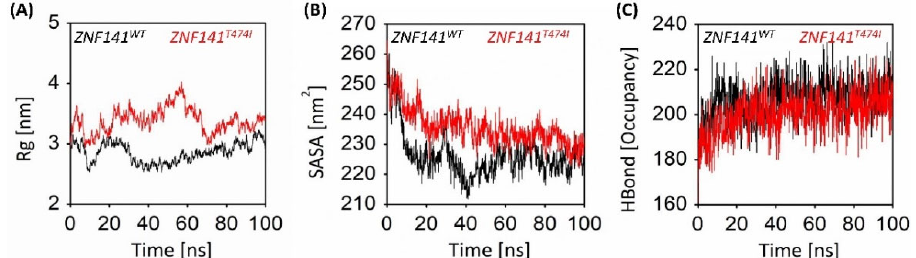
Figure 4. Radius of gyration, Solvent accessible surface area, and Hydrogen bond analysis for ZNF141 protein shows a significant correlation between gyration and solvent accessible area. ( A ) The radius of Gyration analysis for wt-ZNF41 and mutant T474I through the course of 100 ns molecular dynamics simulation. ( B ) The solvent-accessible surface area of wt-ZNF141 protein after 100 ns simulations. ( C ) Hydrogen bond occupancy shows that the number of intra-hydrogen bonds is showing an increasing trend through simulation time.